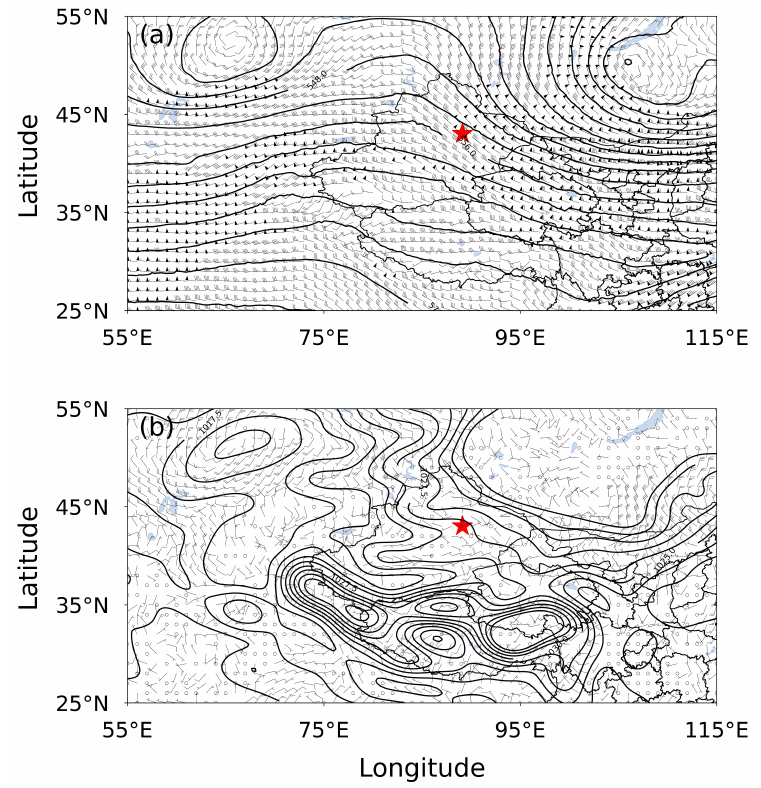
Figure 2. ( a ) The geopotential heights (plotted every ten geopotential meters) and wind field (m s − 1 ) at 500 hPa, and ( b ) the pressure (hPa) and wind field at the surface, at 0:00 AM (UTC) on 29 December 2019. The red stars represent the location of